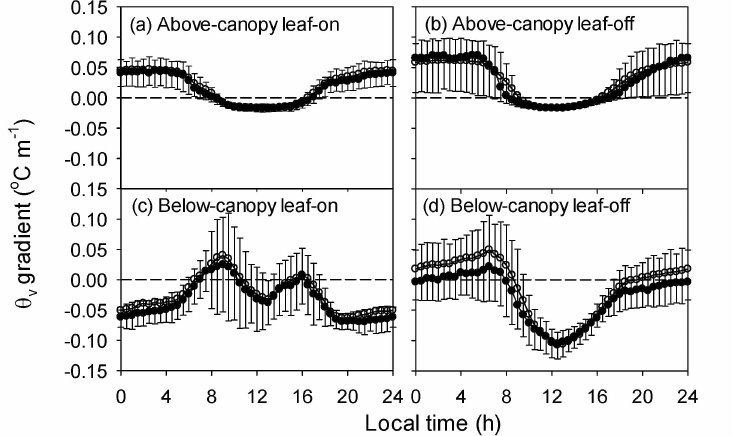
Figure 4. Diurnal courses of the gradients of virtual potential air temperature (θ v ) above (16 m–48 m) and bellow (2 m–16 m) the canopy during the leaf-on and leaf-off seasons of 2012. ( a ) above-canopy for leaf-on season, ( b ) above-canopy for leaf-off season, ( c ) below-canopy for leaf-on season, and ( d ) below-canopy for leaf-off season. Open circles are mean values, filled circles are the median and error bars indicate the range between the 25 and 75 percentile, respectively. The dashed lines are zero